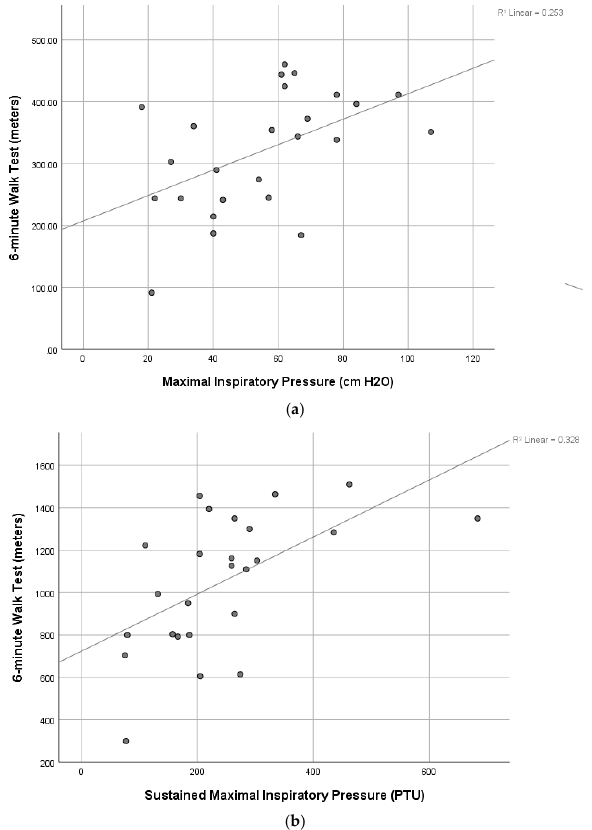
Figure 2. ( a ) . Scatterplot of the relationship between maximal inspiratory pressure and the 6-min walk test. ( b ). Scatterplot of the relationship between sustained maximal inspiratory pressure and the 6-min walk